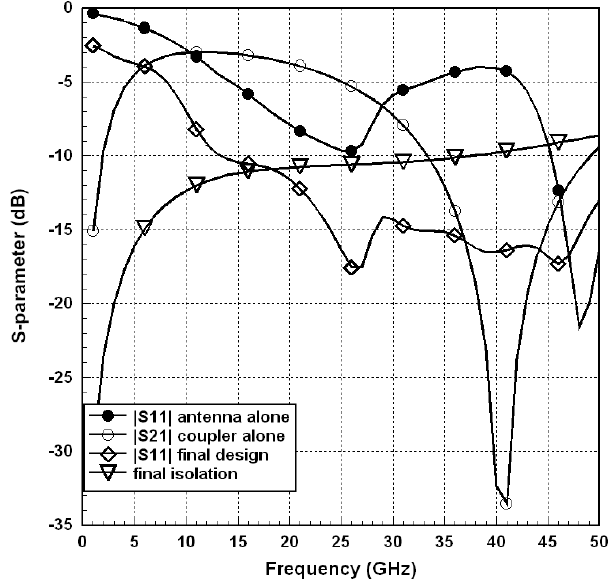
Figure 18. S parameters for coupler alone, antenna alone, and final design. The isolation of port 1 and port 3.